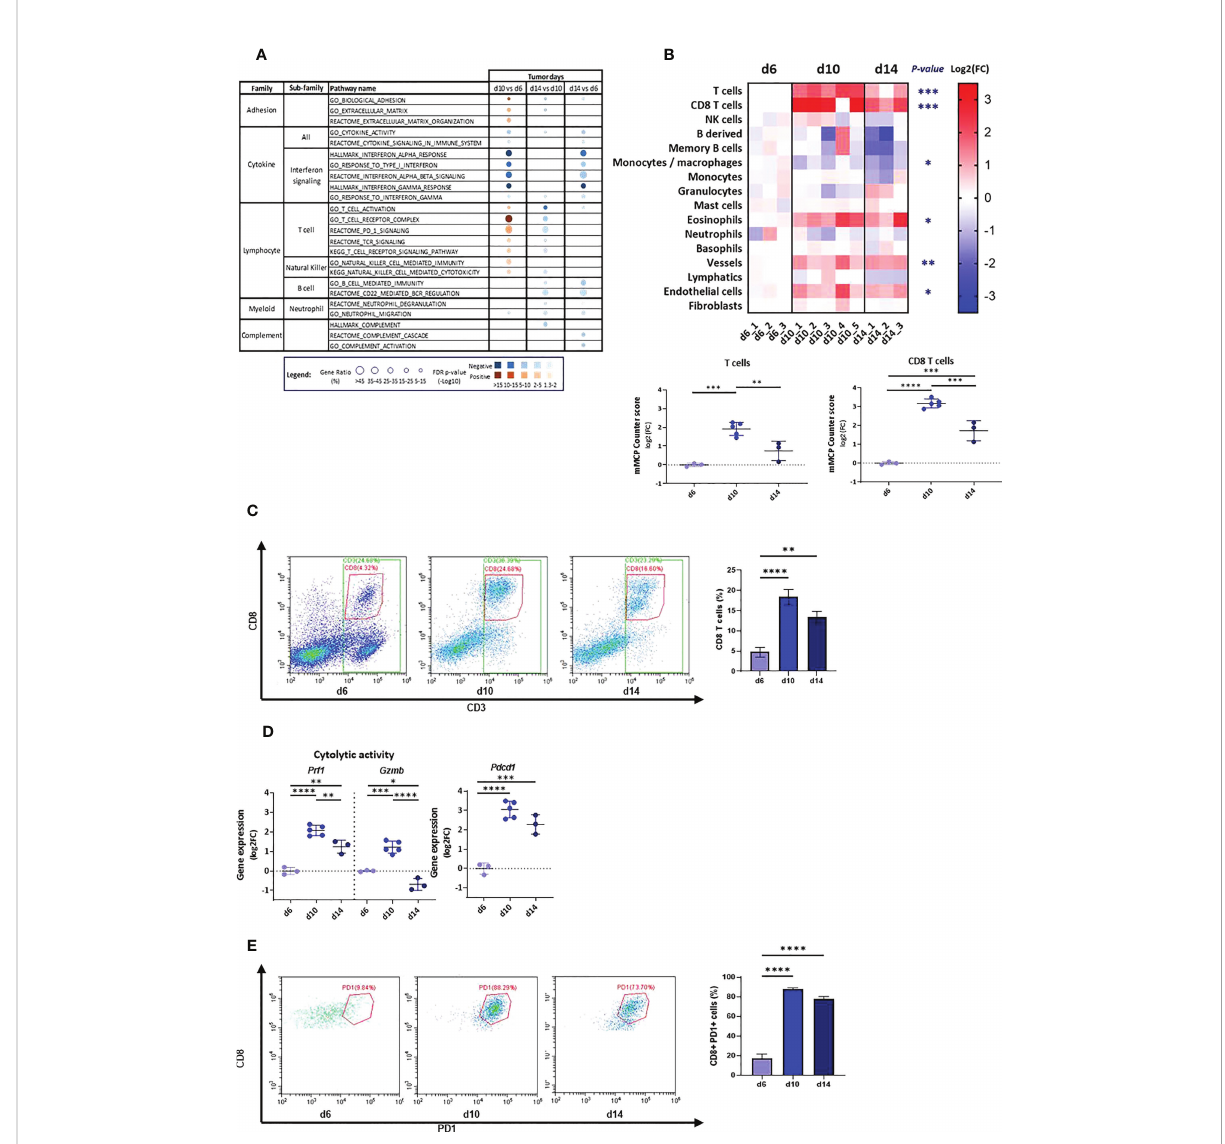
FIGURE 2 Tumor microenvironment in d6, d10 and d14 AB12 tumors. (A) Dysregulated signal pathways between tumors identi fi ed by over-representation analysis. The families and sub-families of the major over-represented signal pathways are shown in the fi gure for each comparison indicated at the top of the fi gure. Over-representation of each pathway, based on underexpressed and overexpressed genes, in blue and brown, respectively, is indicated as a circle, whose size is proportional to the gene ratio and the color gradient represents the FDR p -values. (B) Differential in fi ltration of immune and stromal cell populations between tumors. In the upper part, the fold-changes (FC) in mMCP-counter scores of each cell population are represented as a heatmap. The collect timepoints and the names of the AB12 tumor samples are indicated above and below the heatmap, respectively. The signi fi cant p -values of the ANOVA test are indicated at the left of the heatmap if the FC is higher than 2 in d10 or d14 compared to d6. In the lower part, the dot plots show the FC of T cell and CD8 T cell populations. The FC are relative to the mean scores obtained in d6 tumors. (C) T cell in fi ltration of AB12 tumors identi fi ed by fl ow cytometry. Single cell tumor suspensions, stained with anti CD45, anti CD3 and anti CD8 antibodies, were analyzed using fl ow cytometry. Representative FACS dot plots show the percentage of CD3+, CD8+ and CD3+ CD8-, corresponding to CD3+ CD4+ cells, out of CD45+ cells in the tumors. On the right, the bars show the average percentage of CD3+ PD8+ cells out of CD45+ cells in the tumors (n=3 per time point). (D) Differential expression of T cells cytolytic and activation genes between d6, d10 and d14 AB12 tumors. The dot plots show the FC relative to the mean of the d6 tumor gene expressions of Prf1 (perforin-1), Gzmb (granzyme B) and Pdcd1 (PD-1) genes, based on RNA-Seq data. (E) PD-1 expression on tumor in fi ltrating CD8 T cells identi fi ed by fl ow cytometry. Single cell tumor suspensions, stained with anti CD45, anti CD3, anti CD8 and anti PD-1 antibodies, were analyzed by fl ow cytometry. Representative FACS dot plots show the percentage of CD8+ PD-1+ cells out of CD3+ cells in the tumors. On the right, the bars show the average percentage of CD8+ PD-1+ cells out of CD3+ cells in the tumors (n=3 per time point). The p - values of the post hoc Tukey test are indicated at the top of the dot plots and of the histogram (B, D and E). FC: Fold-Change. * p ≤ 0.05; ** p ≤ 0.01; *** p ≤ 0.001; **** p ≤